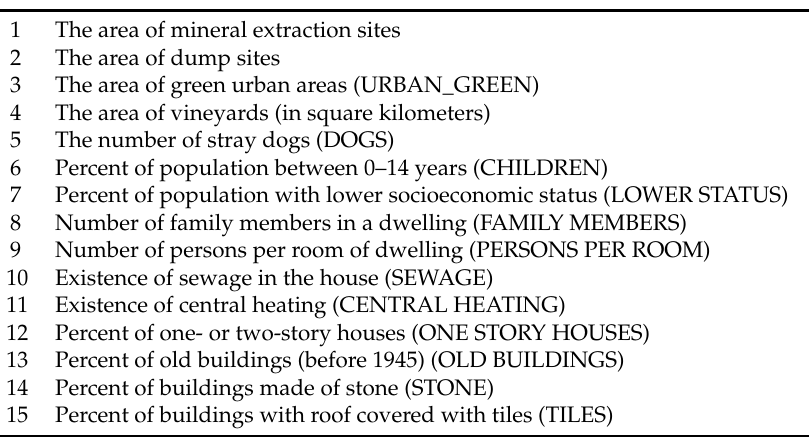
Table 1. Explanatory variables for human VL